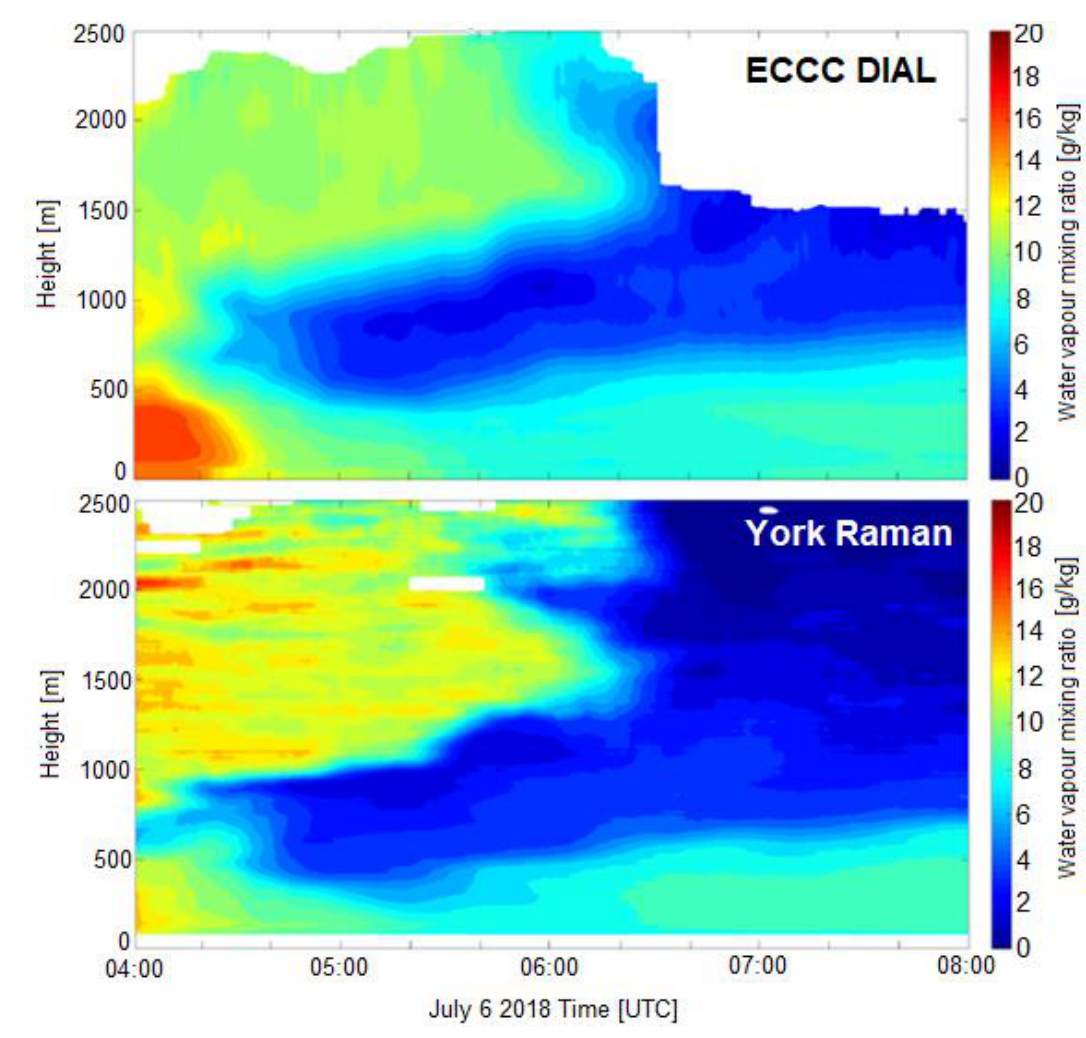
Figure 5 . Water vapor profile observations from the DIAL ( top ) and York Raman lidar ( bottom ) on July 6 2018 during the passage of a cold front.